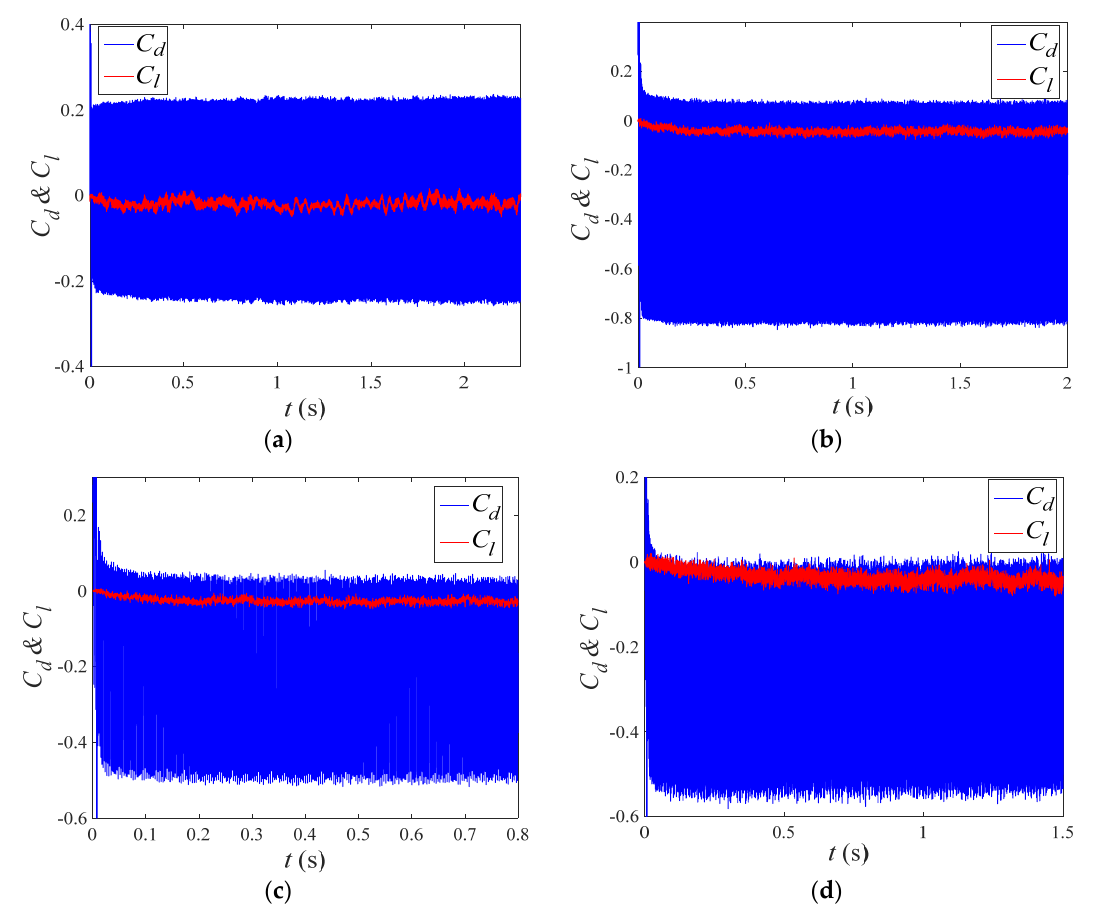
Figure 12. Lift and drag coefficients under different wave numbers. ( a ) N = 3. ( b ) N = 4. ( c ) N = 5. ( d ) N = 6.